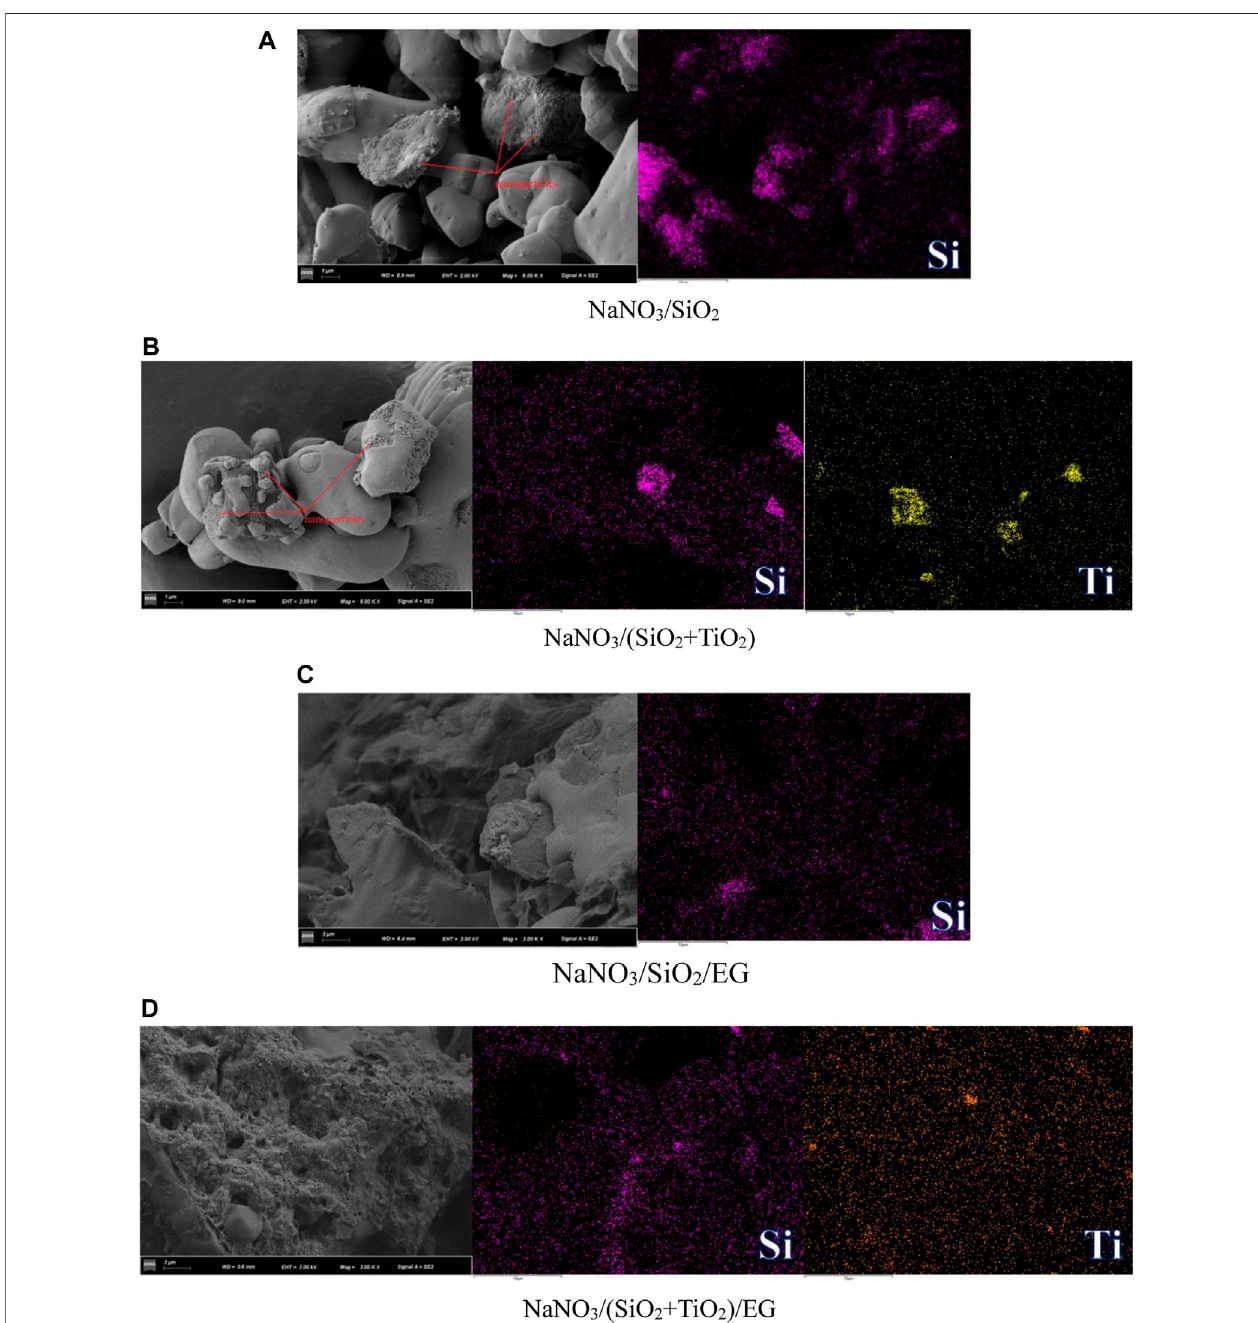
FIGURE 6 | EDS element mapping images of different samples. (A) NaNO3/SiO2. (B) NaNO 3 /(SiO 2 +TiO 2 ). (C) NaNO 3 /SiO 2 /EG. (D) NaNO 3 /(SiO 2 +TiO 2 )/EG.